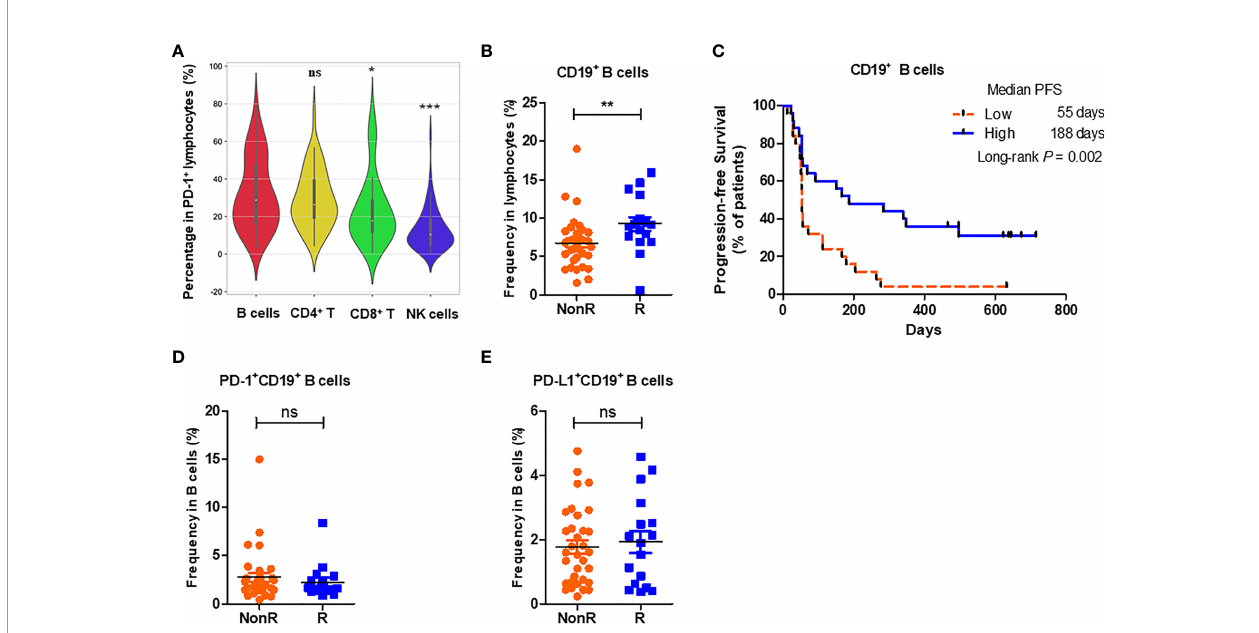
FIGURE 1 | High percentages of CD19 + B cells at the baseline are associated with better responses to nivolumab monotherapy. (A) The average percentages of B cells (CD3 - CD19 + ), CD4 + T cells (CD3 + CD8 - ), CD8 + T cells (CD3 + CD8 + ) and NK cells (CD3 - CD16 + ) in PD-1 + lymphocytes in the periphery of advanced NSCLC patients (n = 50) before nivolumab treatment. (B) Comparison of the frequencies of CD19 + B cells between R (n = 17) and NonR (n = 33) NSCLC patients receiving anti-PD-1 monotherapy at the baseline. (C) Kaplan-Meier analysis of the associations of the percentages of CD19 + B cells with the PFS values. (D, E) Comparison of the frequencies of PD-1 + CD19 + B cells (D) and PD-L1 + CD19 + B cells (E) between R (n = 17) and NonR (n = 33) NSCLC patients at the baseline. The Wilcoxon test was used to analyze the differences between two groups. Survival curves were plotted by using the Kaplan-Meier method with the median as the cutoff to de fi ne the high and low group. P -values were calculated by the log-rank statistics in Kaplan-Meier analyses. *** P < 0.001, ** P < 0.01, * P < 0.05, ns, P >